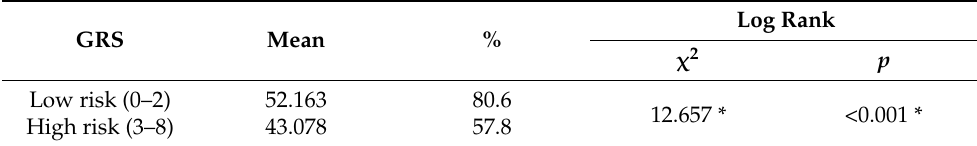
Table 6. Kaplan–Meier survival curve for recurrence free survival with